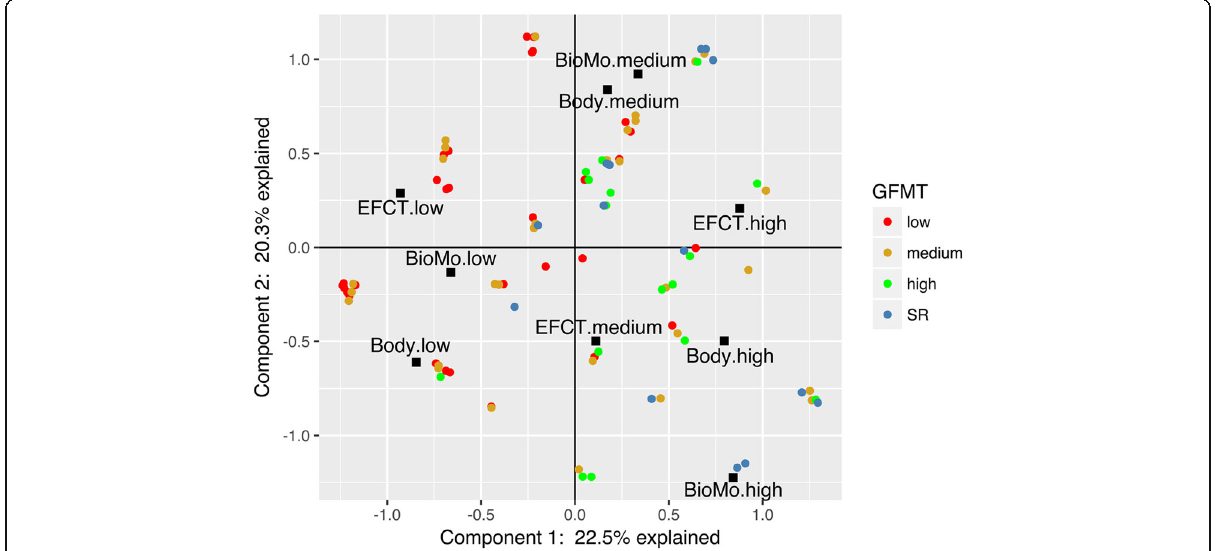
Fig. 4 Correspondence analysis plot. Component 1 (x axis) represents performance accuracy for all tasks. This is a bi-plot which shows participants (circles) in the same plot as the levels of the variables (squares). Each circle represents the score of a single participant, colour coded by that participant ’ s face-recognition ability on the Glasgow Face Matching Test (GFMT) (low, red; medium, orange; high, green; SR (top-performers); blue). The similarity between the squares and the circles is shown by their angular distance relative to the origin of the